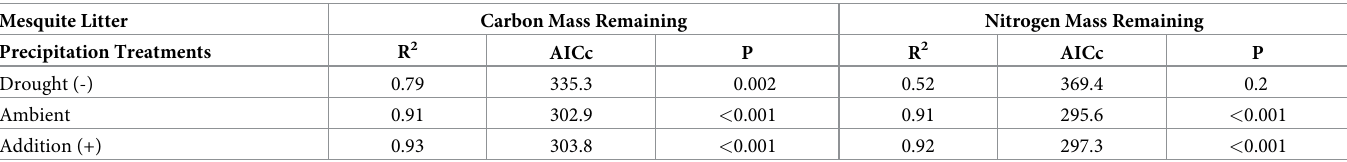
Table 3. Simple linear regression results of the relationship between ash-free dry mass remaining (%) of mesquite litter and mass remaining (%) of carbon and nitro- gen of mesquite litter for each of the three precipitation manipulation treatments. Cellulose and basswood were not included in this analysis due to their negligible decomposition. Mesquite